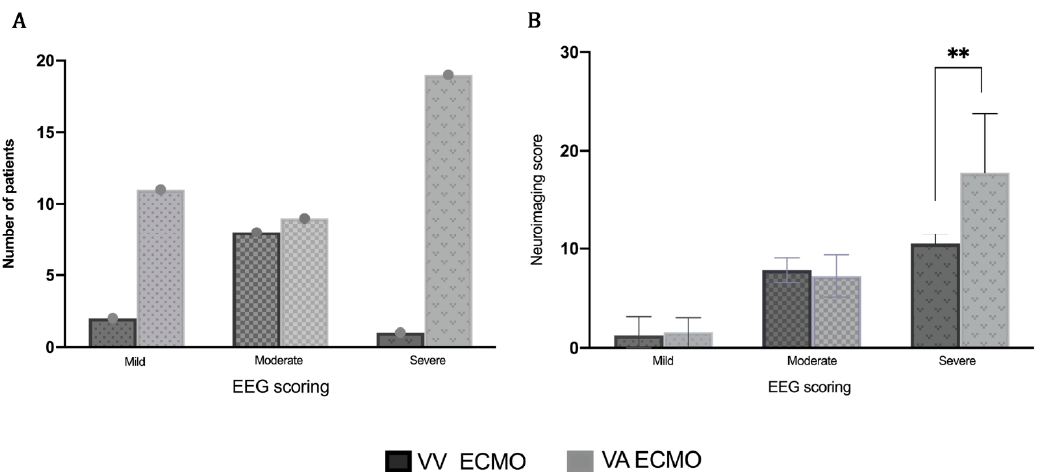
Figure 3. Severity of EEG scores and neuroimaging scores for VA and VV ECMO group patients. The EEG severity is noted across the x-axis in both graphs. ( A ): The number of patients is on the y-axis. VV ECMO is demonstrated in dark gray and VA ECMO in light gray. Patients on VA ECMO show a higher severity of EEG scores ( p = 0.007). ( B ): The neuroimaging severity score is on the y-axis. VV ECMO is demonstrated in dark gray and VA ECMO is in light gray. Patients showed a statistically significant progression in the severity of their EEG score in relation to their neuroimaging score severity ( p < 0.0001). EEG: electroencephalogram; VA: veno-arterial; VV: veno-venous; ECMO .